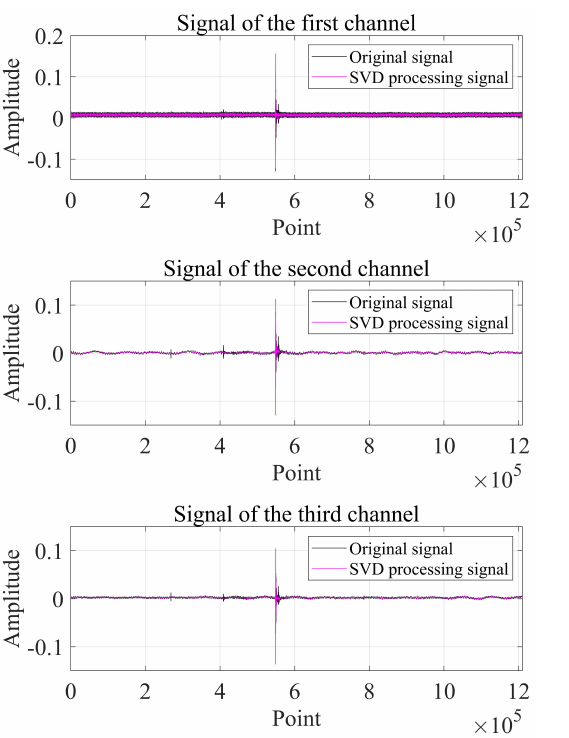
Figure 17. Comparison of the original value of the three-channel signal and the noise reduction value.